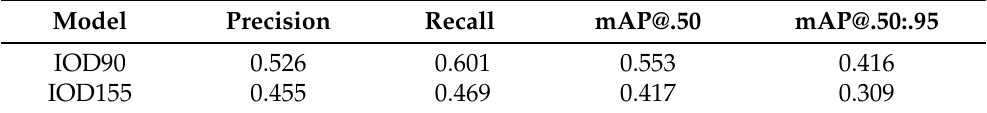
Table 1. Evaluating